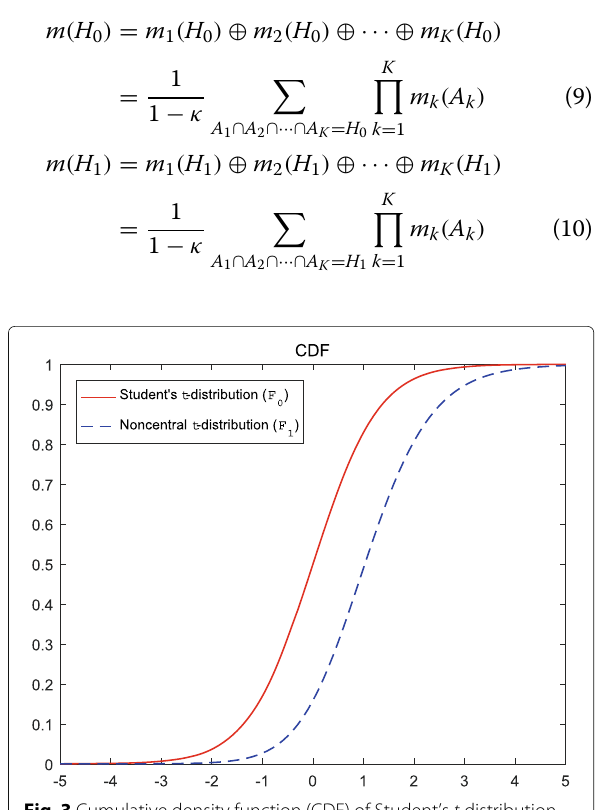
Fig. 3 Cumulative density function (CDF) of Student’s t distribution and the non-central t